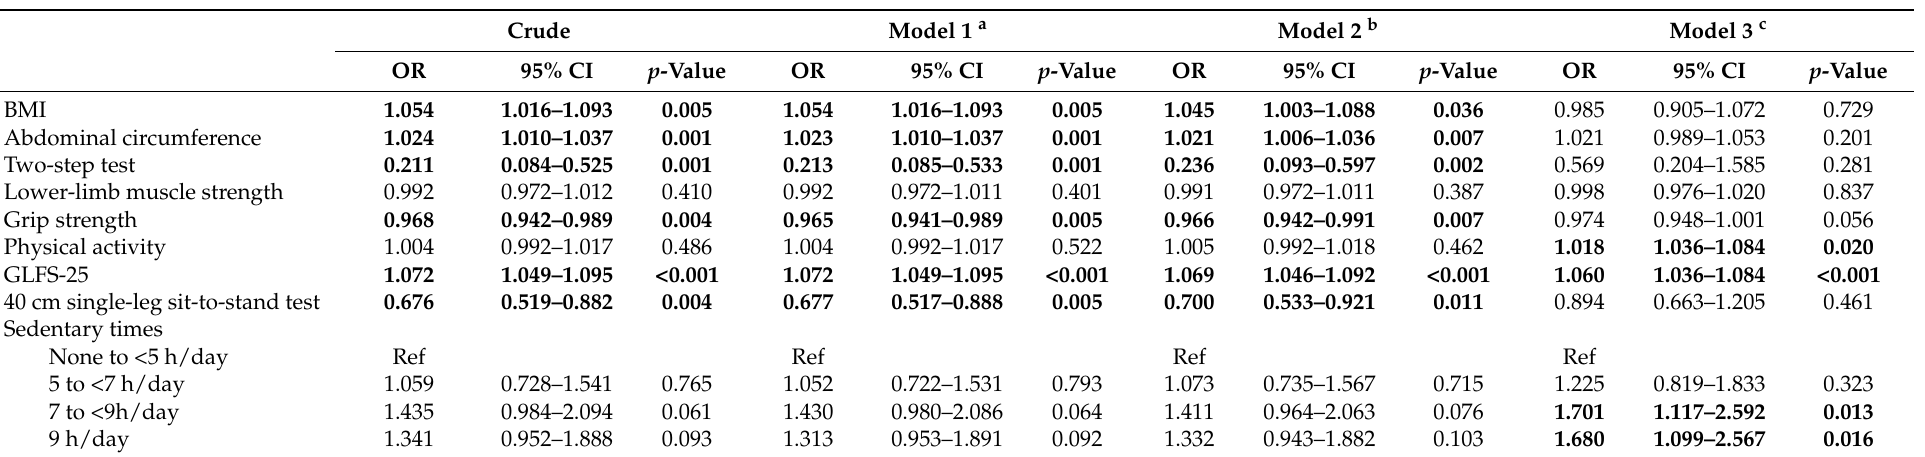
Table 3. Crude and adjusted odds ratio for the risk of